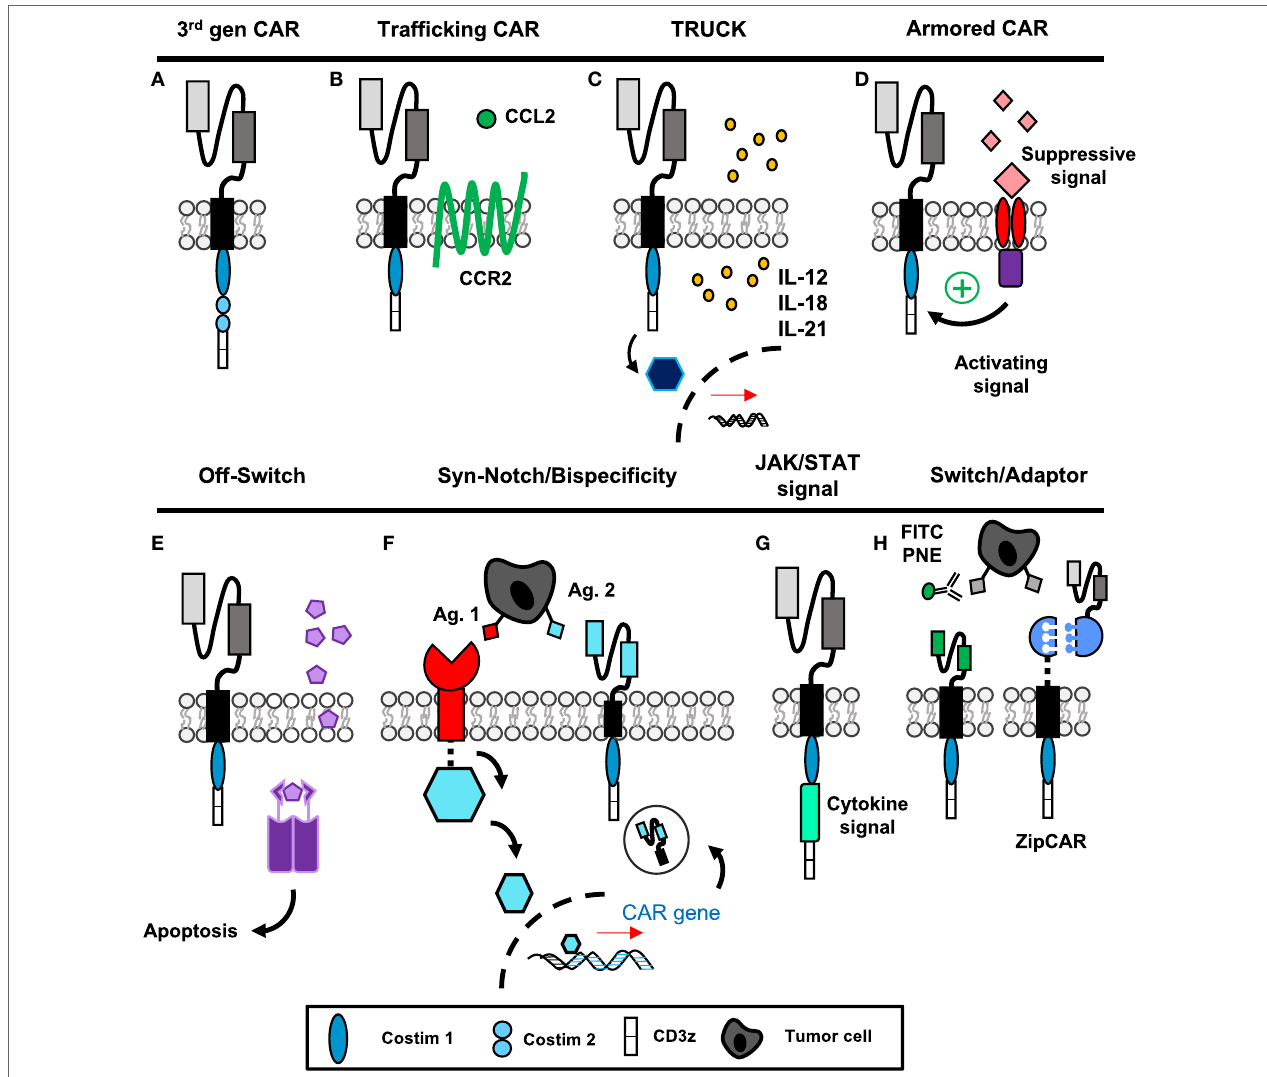
FigURe 2 | “Fourth-generation” chimeric antigen receptor (CAR) constructs incorporate novel mechanisms to enhance targeted antitumor efficacy. (A) The third-generation CAR incorporates the extracellular scFv with intracellular CD3 ζ signaling and two tandem costimulatory domains. (B) CAR T cells with additional chemokine receptors have improved trafficking to tumors. (C,g) T cells secreting additional cytokines or engineered with cytokine signaling domains have enhanced activation and can modulate surrounding microenvironment. (D) Armored CARs redirect suppressive signals from the tumor to activating signals to resist exhaustion. (e) Suicide genes and (F) bispecificity mitigate off-tumor toxicity through the ability to deplete transferred cells or enhance specific targeting to tumors, respectively. (H) Switchable CAR targeting via adaptor molecules provides versatile opportunity to control CAR activation, specificity, and longevity after transfer of cells. Abbreviations: Ag, antigen; PNE, peptide